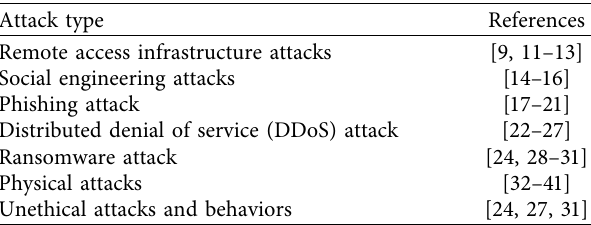
Table 1: Pandemic cybersecurity classifications. Attack type